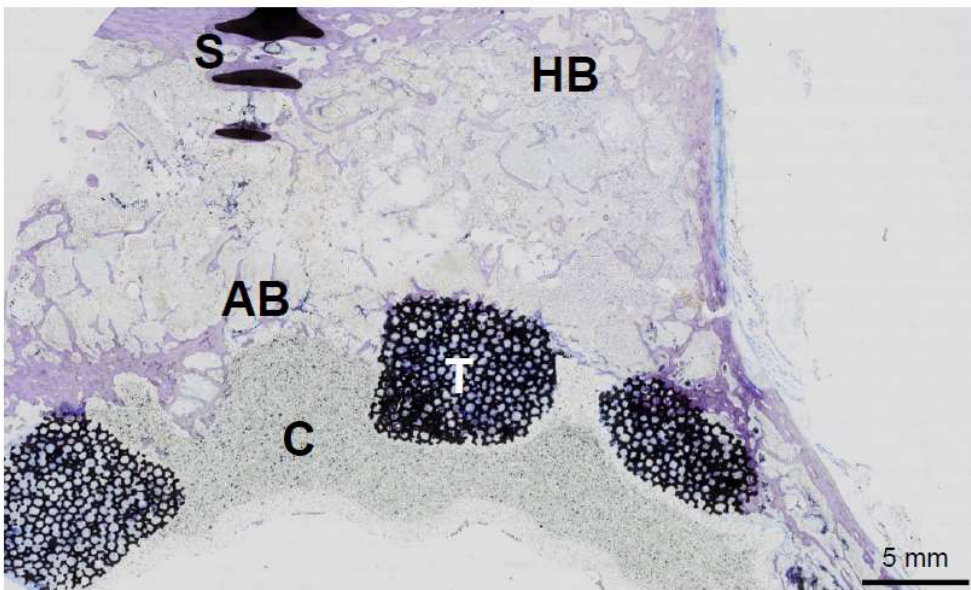
Figure 3. The ground section of an acetabulum that was explanted from a patient years after revision arthroplasty. HB: host bone AB: allograft bone, S: screw, T: tantalum augmentation, C: bone cement. The allograft has been incorporated by the host bone, while additional bone growth on the tantalum can be seen.